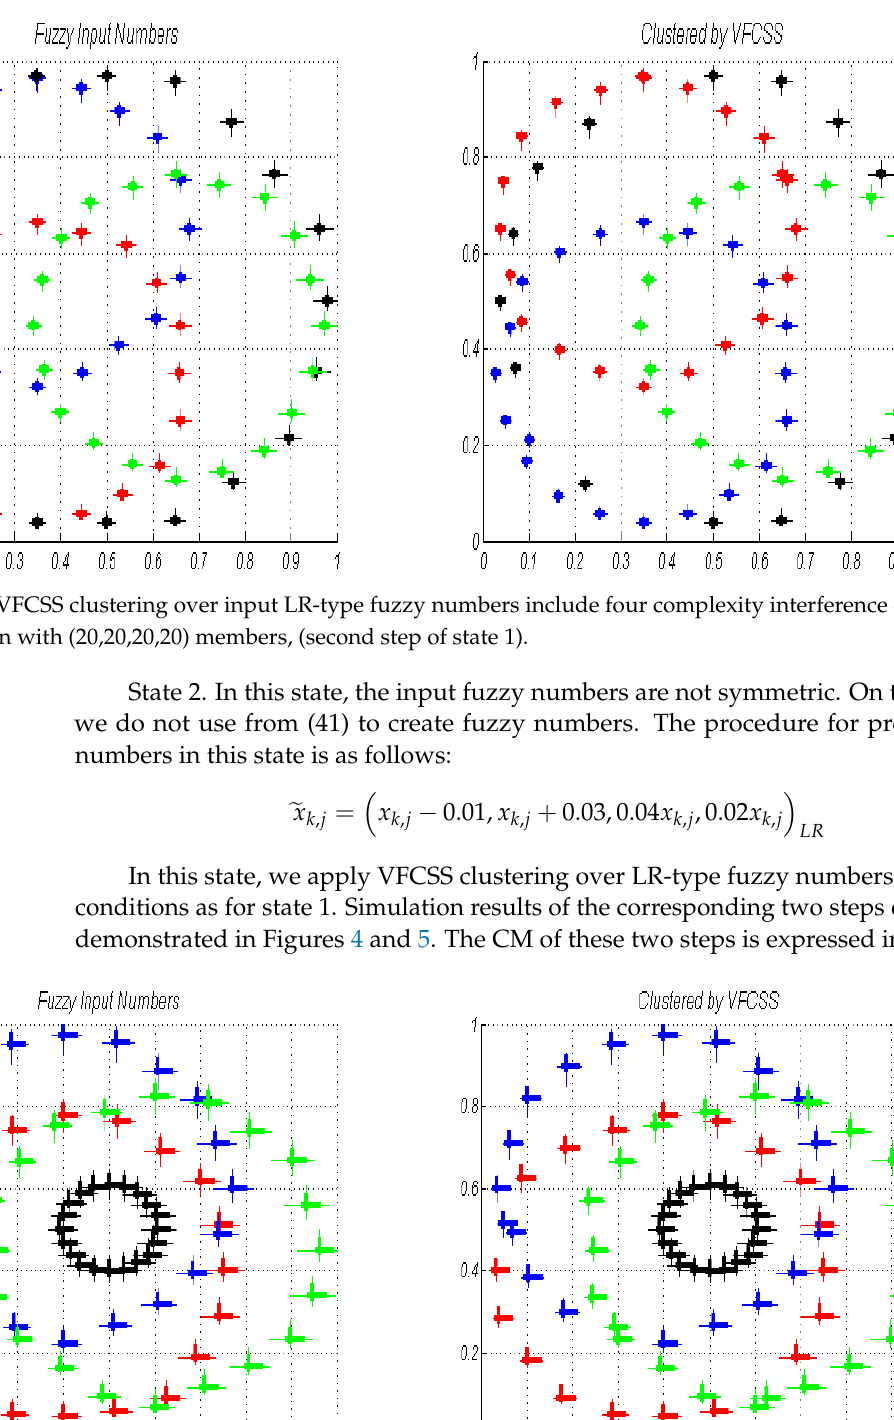
Figure 2. Proposed VFCSS clustering over input LR-type fuzzy numbers include four interference classes red, blue, black and green with (20,20,20,20) members, (first step of state 1).